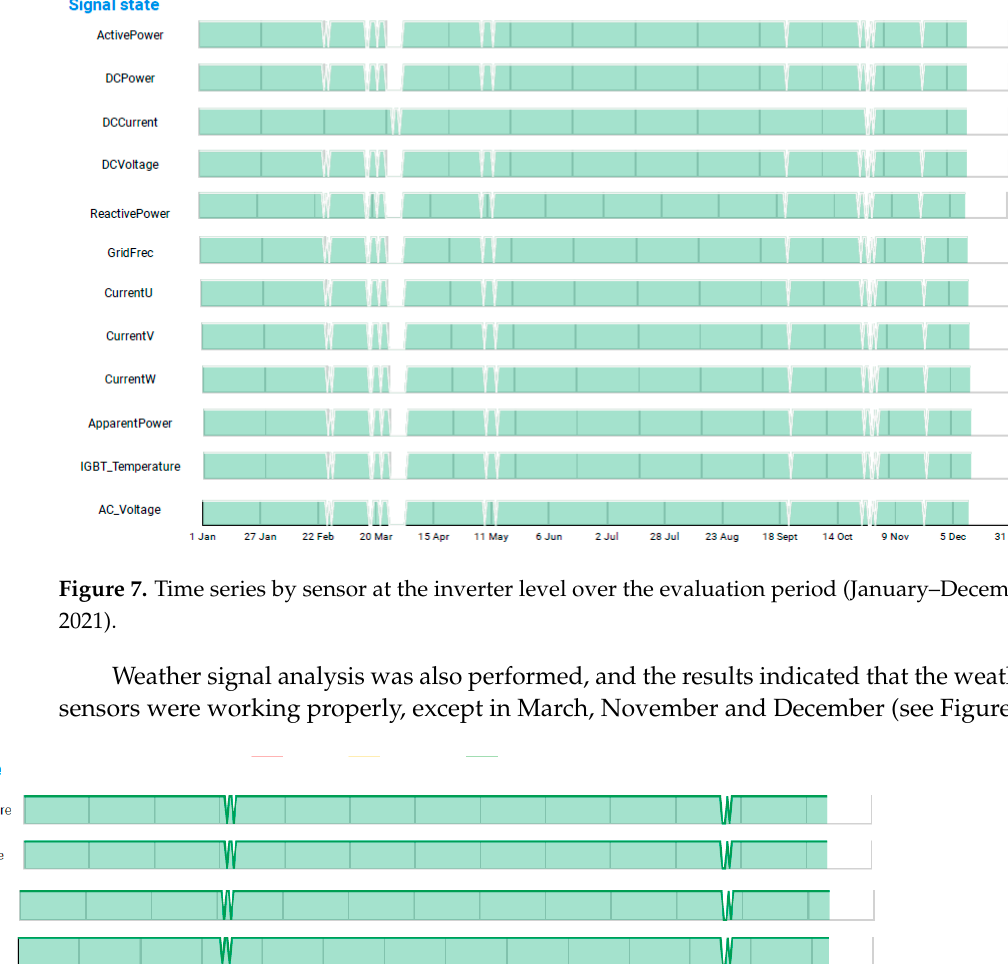
Figure 9. Data quality of the test PV plant over the evaluation period (January–December 2021). Once the data were cleansed, ML predictive models were used to simulate the PV system performance at the inverter level. The results of the models used to predict DC power and voltage of the test PV plant in January 2021 are depicted in Figure 10. The predictive models performed well for simulating the electrical characteristics of the PV system, and they were relatively accurate, exhibiting good agreement with the measured data. Indications of fault occurrences were evident when discrepancies between the PV system measured and predicted power were detected (e.g., 27th of January 2021).